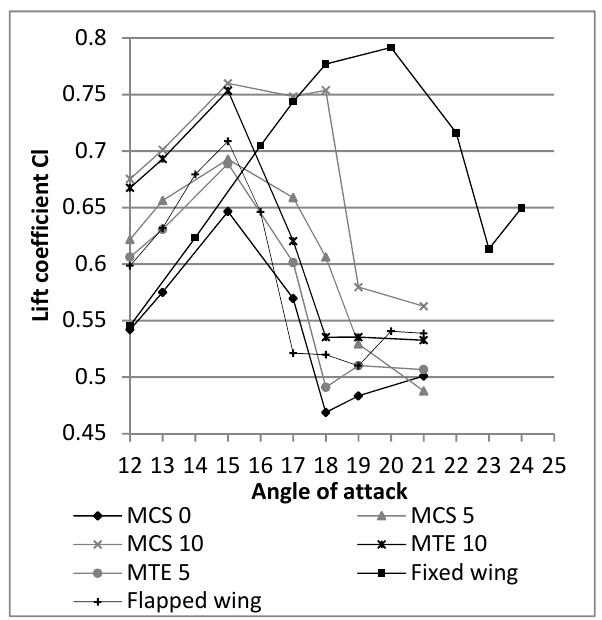
Figure 19. Lift coefficient variation with the angle of attack around the stall angle. Figure 19. Lift coe ffi cient variation with the angle of attack around the stall